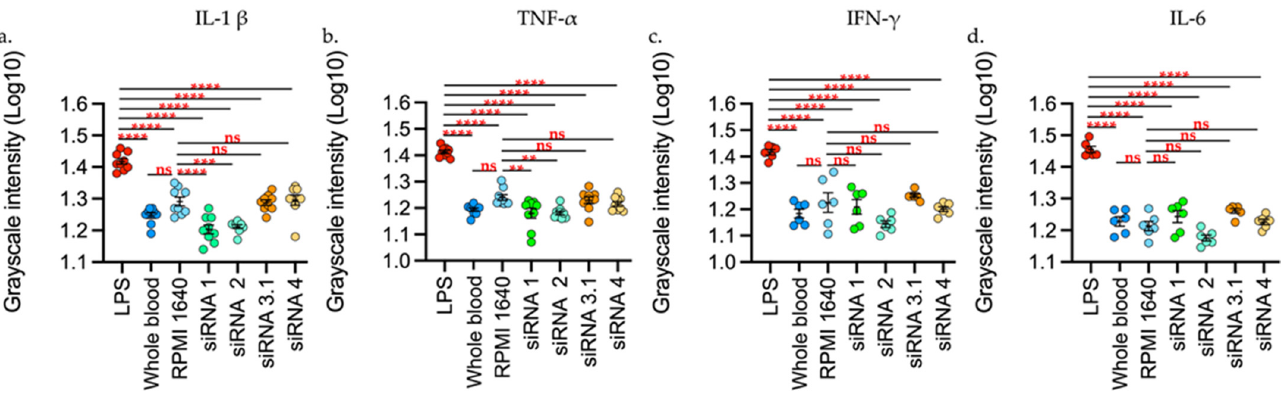
Figure 3. L-siRNAs did not increase the interleukins levels evaluated. ( a ) L-1 β . ( b ) TNF- α . ( c ) IFN- γ . ( d ) IL-6. The stimuli are given by: LPS (Lipopolysaccharide 100 ng/mL), RPMI 1640, liposomes- siRNA (L-siRNA1, L-siRNA2, L-siRNA3.1, L-siRNA4. As negative control, blood was used without stimulus (blood). Data are expressed as Mean + SEM of the three independent assays in triplicate. The measurement is given by the intensity in grayscale in an equivalent area in all the samples (911 square pixels). ** p < 0.001 *** p < 0.0001 **** p < 0.00001. The measurement was performed with Fiji and was represented as Log 10 through GraphPad Prism 9.